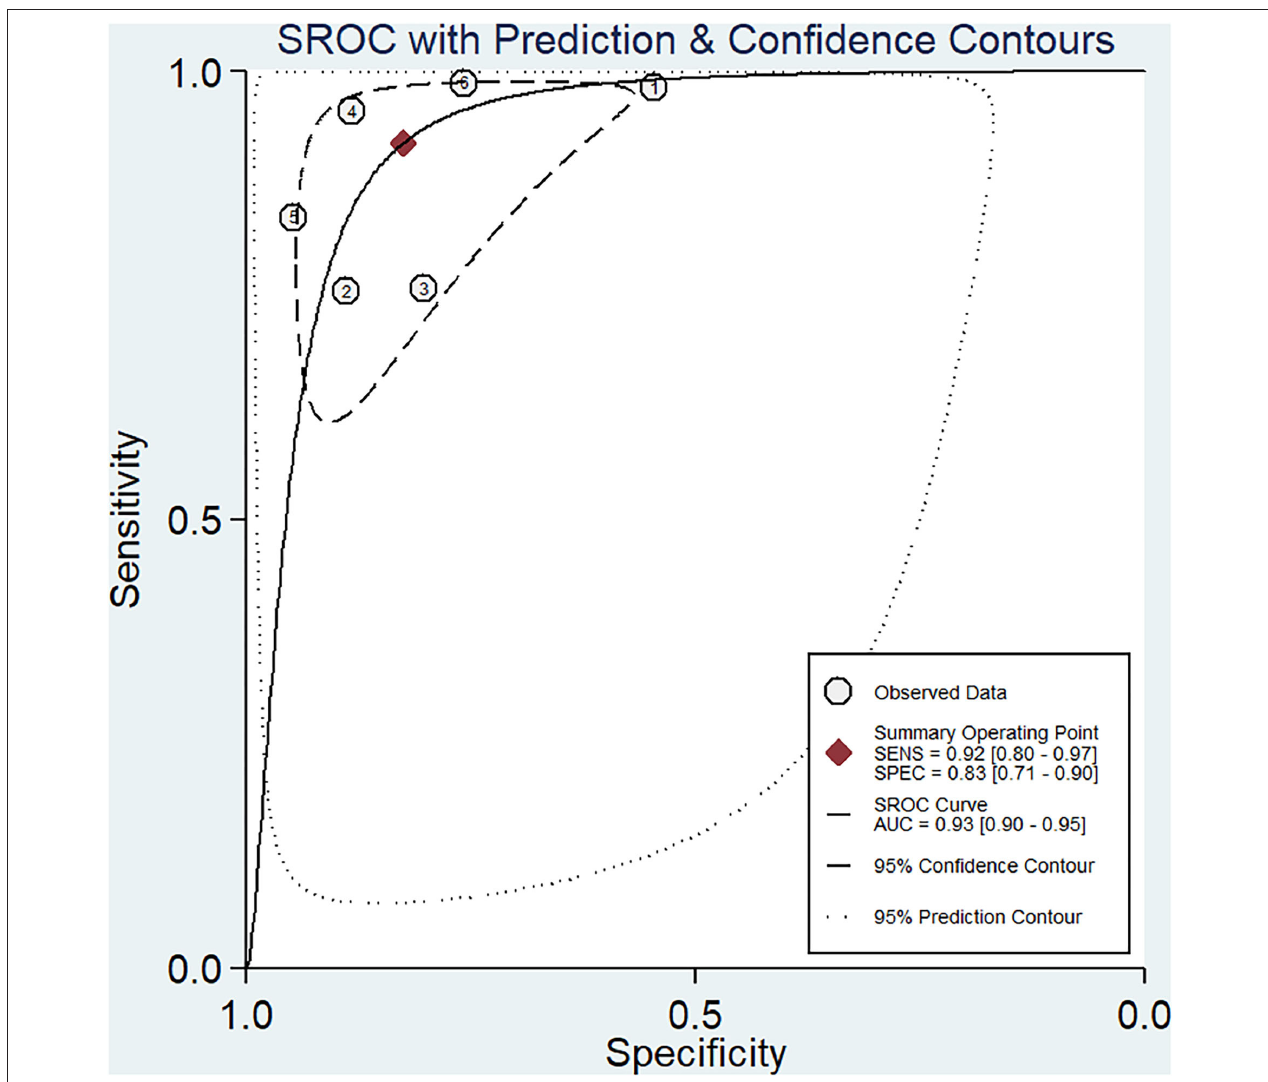
FIGURE 4 | Summary receiver operating characteristic (SROC)